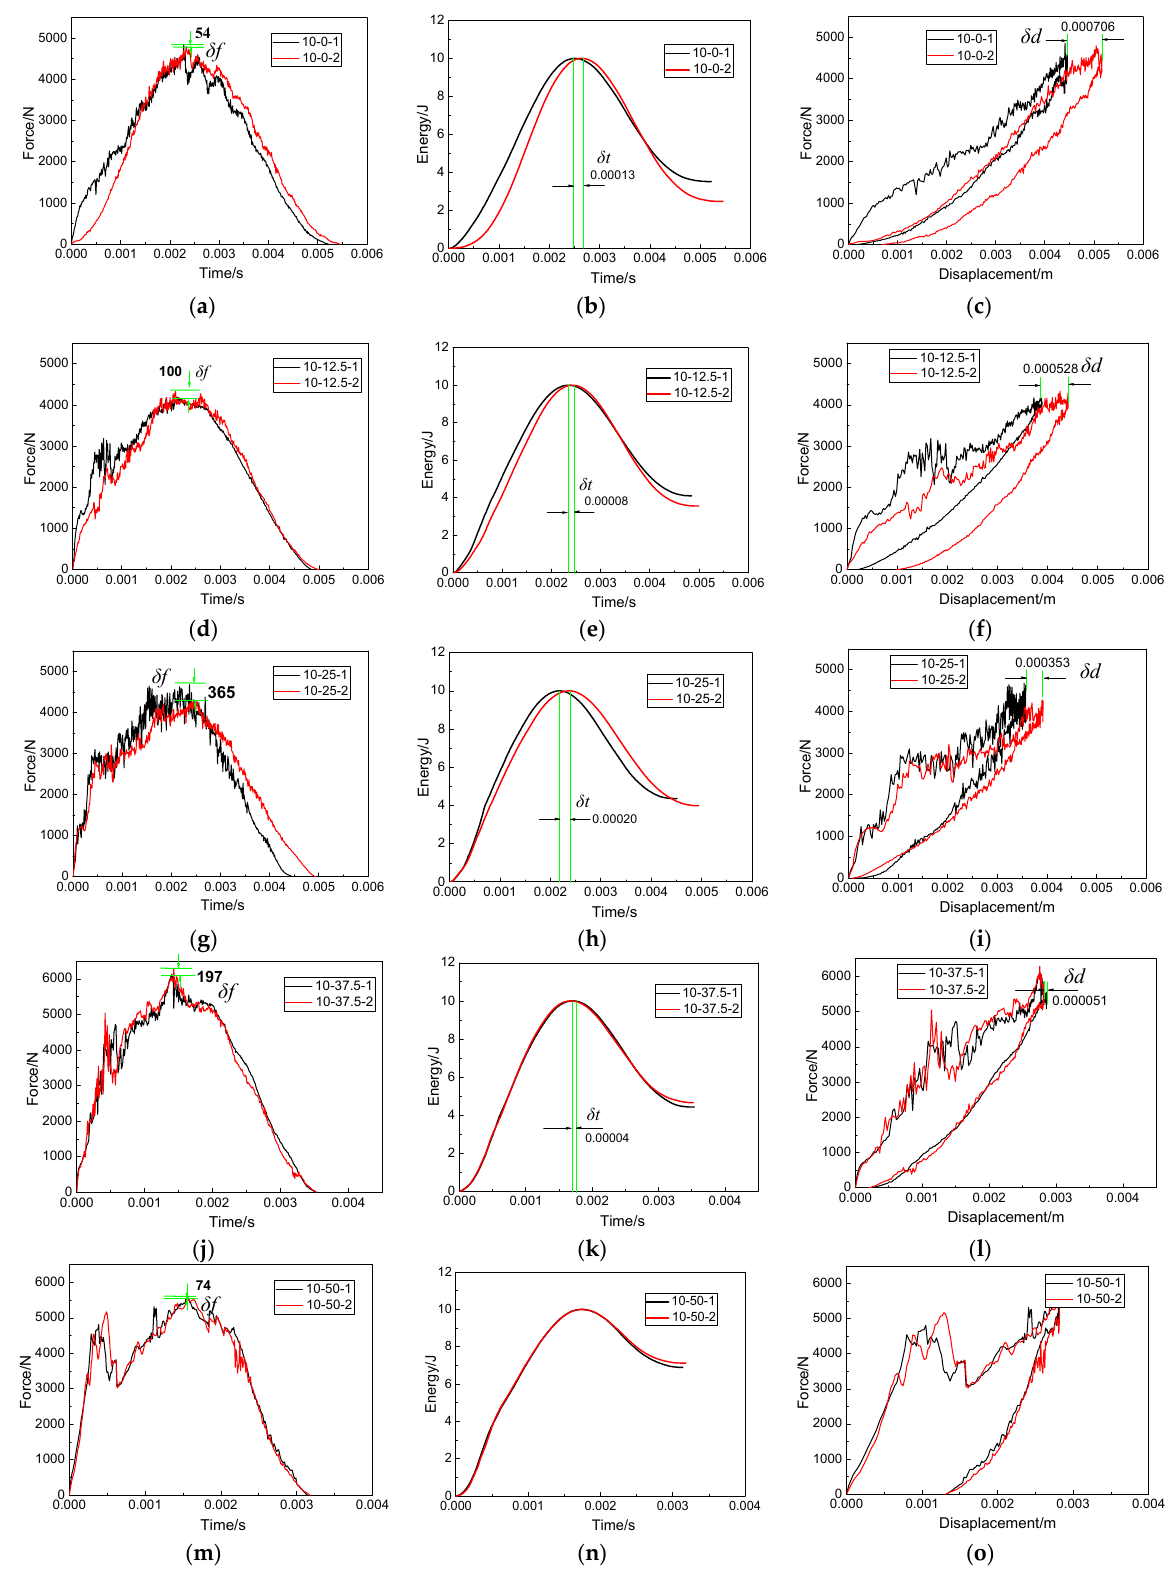
Figure 13. Force–time curves ( a,d,g,j,m ), absorbed energy curves ( b,e,h,k,n ) and force–displacement curves ( c,f,i,l,o ) under double impacts at the impact distances of 0 mm–50 mm, with the impact energy of 10 J. When the impact distance continued to increase to 50 mm, due to the weak interac- tion between the first impact and the second impact, the force–displacement curves of the two impacts maintained a similar trend. Furthermore, 𝛿 (cid:3031) was extracted to analyze the displacement interference degree between the first impact and the second impact. It was not difficult to find that the maximum displacement difference decreases with the in- crease in impact distance. The displacement interference between the first impact and the second impact decreased gradually with the increase in impact distance. Delamination Damage